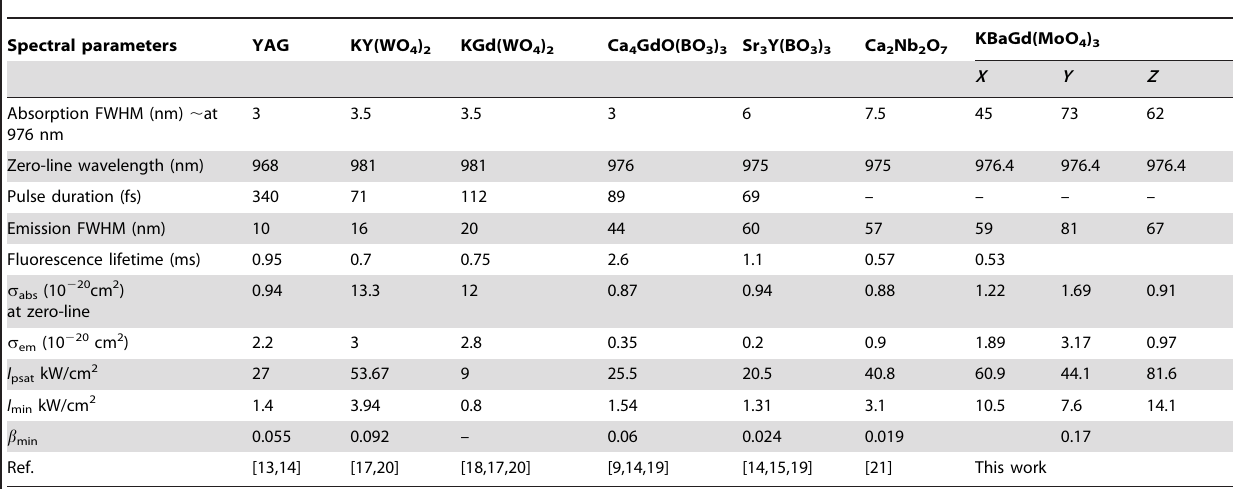
Spectral parameters